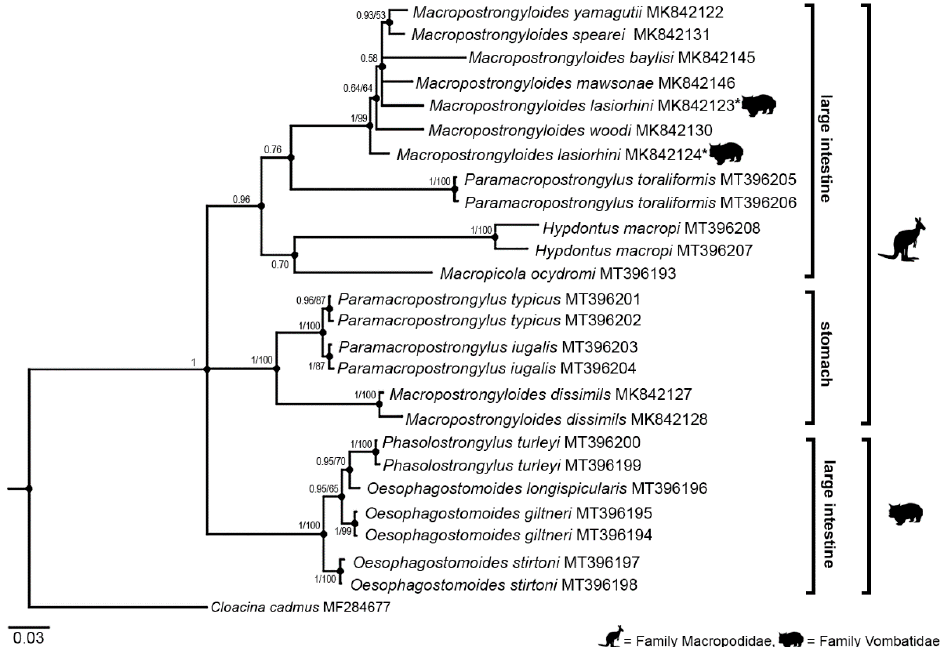
Figure 1. Phylogenetic analysis of the ITS+ rDNA sequences the Phascolostrongylinae species from macropodid (kangaroo icon) and vombatid (wombat icon) hosts. The sequence data were analysed using the Bayesian Inference (BI) and Neighbour ‐ Joining (NJ) methods. Nodal support is given as a posterior probability followed by bootstrap value for BI and NJ, respectively. Cloacina cadmus from the quokka, Setonix brachyurus (GenBank accession no. MF284677), was used as the outgroup. The scalebar indicates the number of inferred substitutions per nucleotide site.